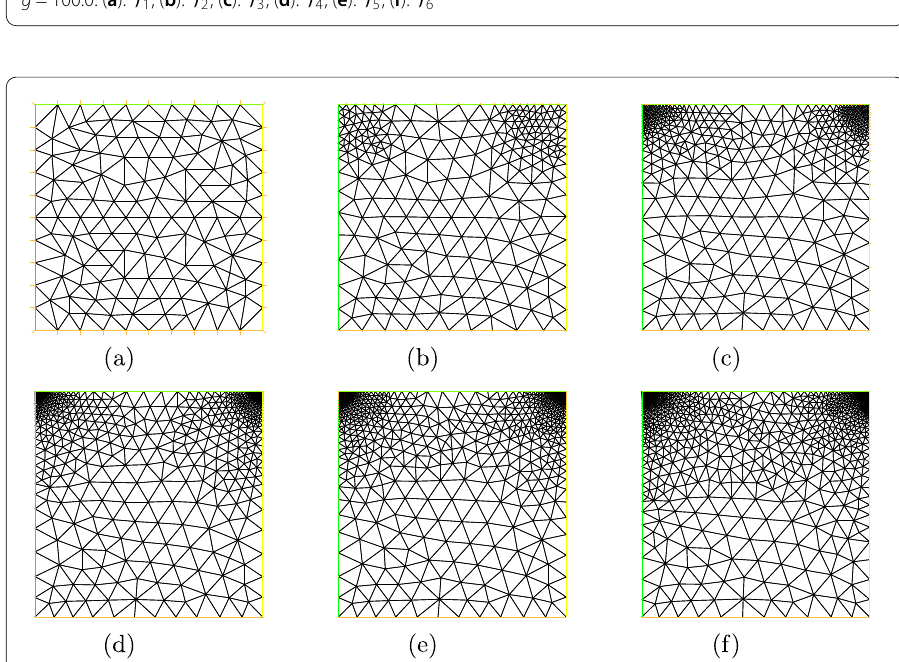
Figure 7 Adaptive refinements by P 1 – P 0 stabilized method for the cavity flow with slip boundary condition: g = 100.0. ( a ): T 1 ; ( b ): T 2 ; ( c ): T 3 ; ( d ): T 4 ; ( e ): T 5 ; ( f ): T 6